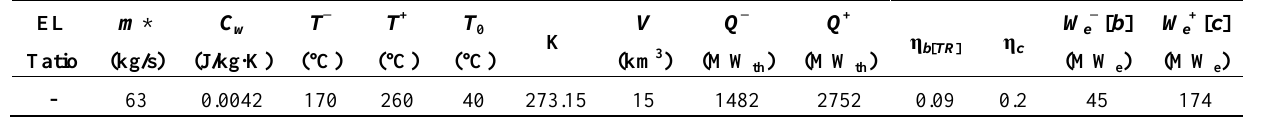
* Arithmetic mean computed starting from Q